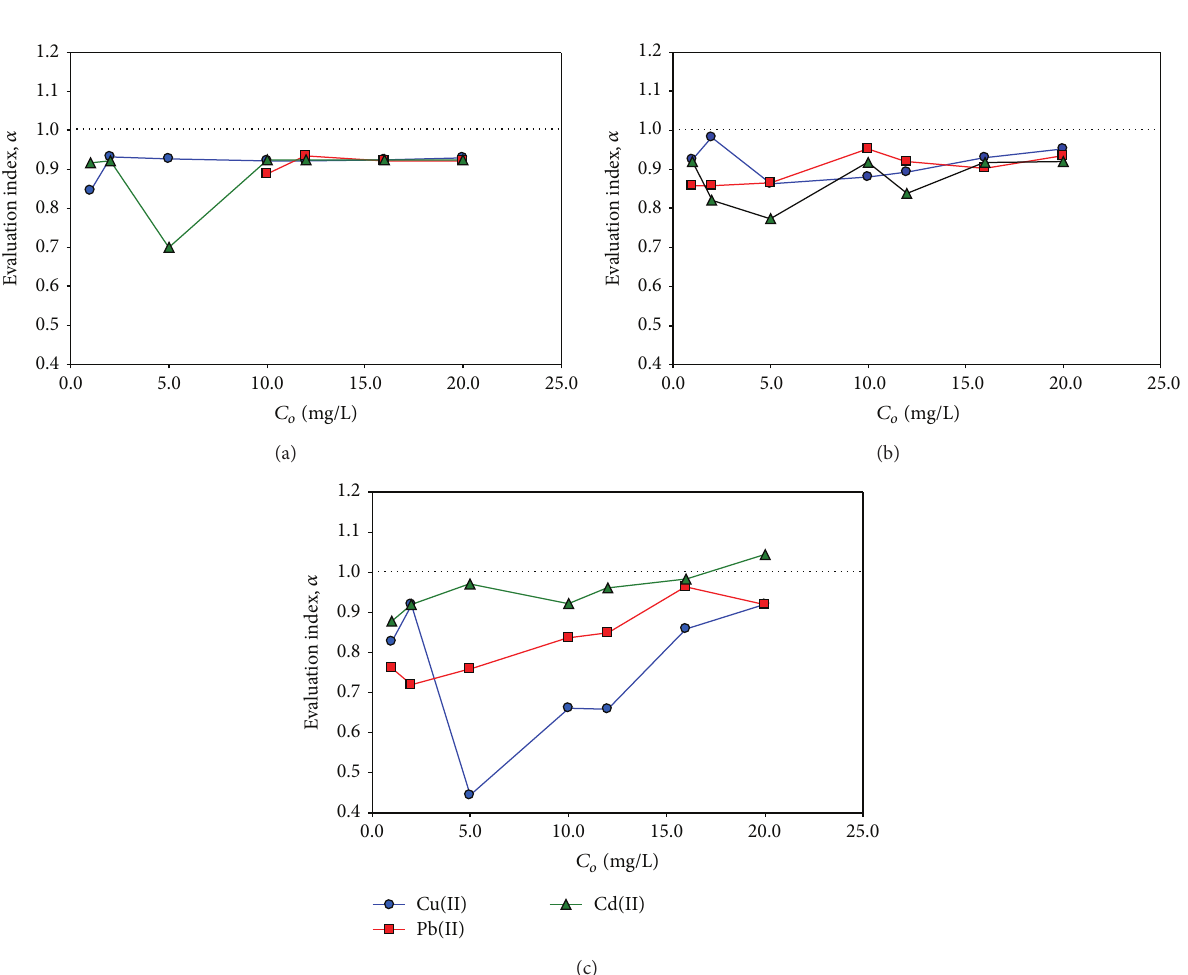
Figure 6: The evaluation index (a) for SRFA effects on metal adsorption on magnetic GO (a), PAC (b), and MWCNT (c) as a function of the initial metal concentrations ( 𝐶 𝑜 ). The first three data points of Pb(II) on the magnetic GO were neglected because of the extremely low equilibrium concentrations ( 𝐶 𝑒